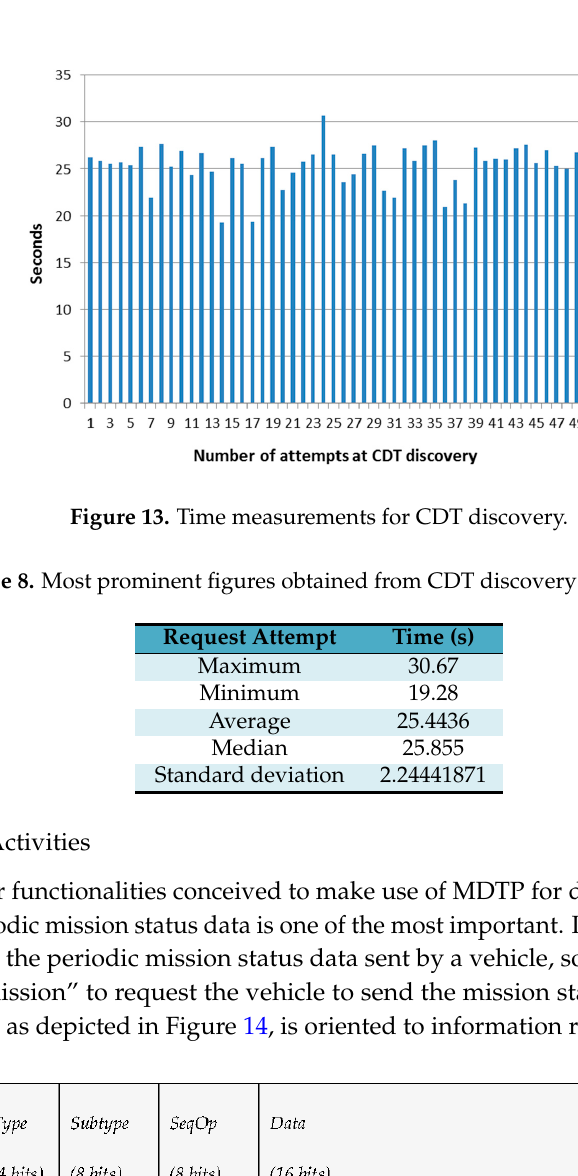
Figure 12. PDU used for CDT discovery.